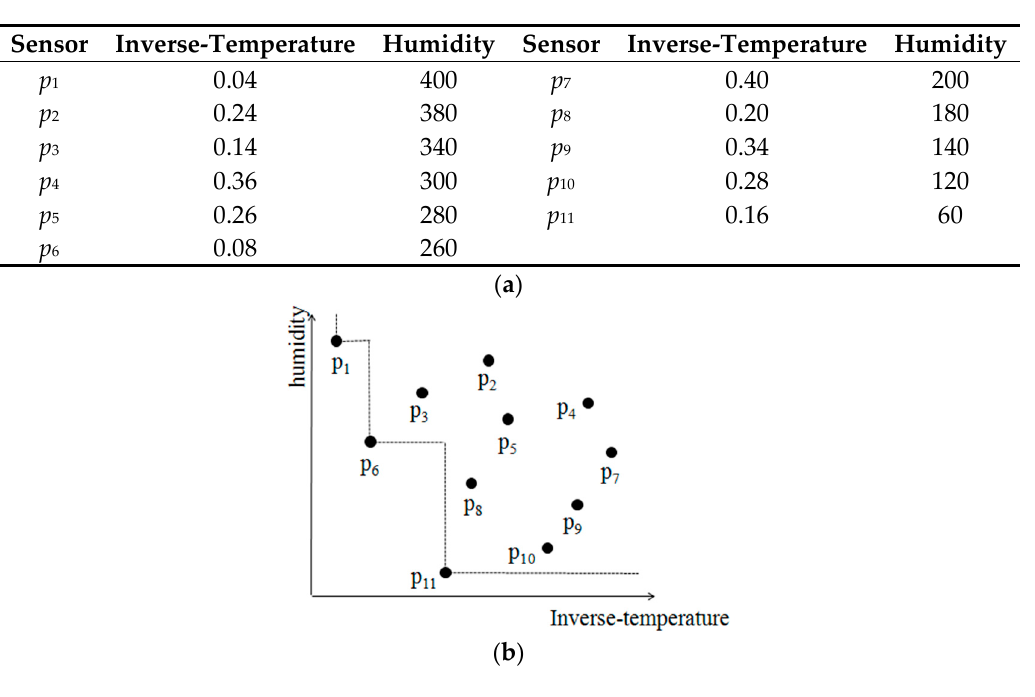
Figure 1. An example of skyline. ( a ) Dataset D ; ( b ) Points of D in two dimensional space.